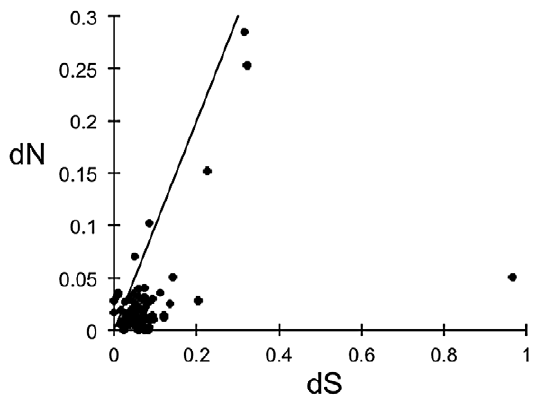
Figure 2. Number of nonsynonymous substitutions per non- synonymous site (dN) plotted against the number of synony- mous substitutions per synonymous site (dS) in 86 Acropora millepora – A.palmata putative homologous pairs. The line shows the neutral expectation (dN=dS).